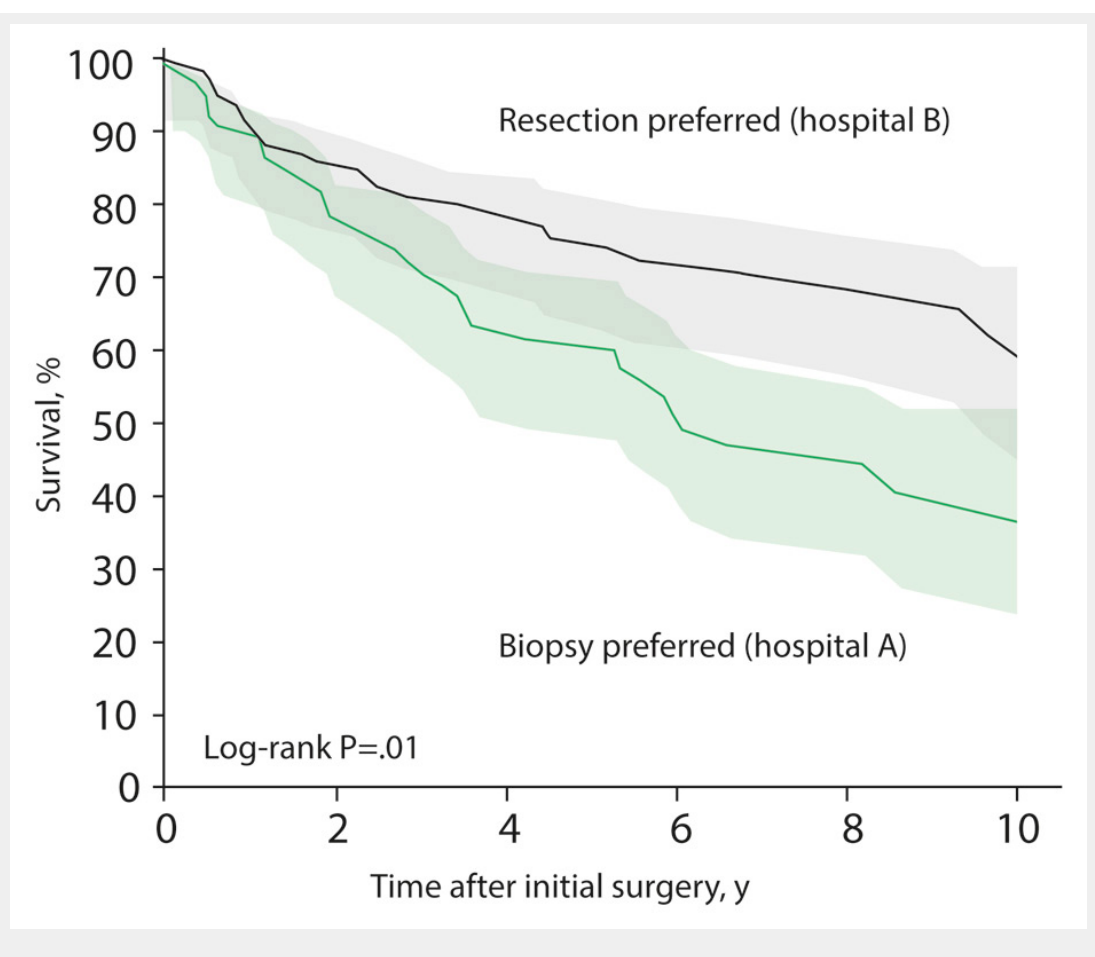
Figure 1 Patient survival according to hospital treatment strategy. Patients treated at a hospital that favoured a pro-active strategy with early radical resection for low-grade glioma had an improved survival time compared with patients treated in a hospital that followed a “wait-and-see” strategy after biopsy [4].